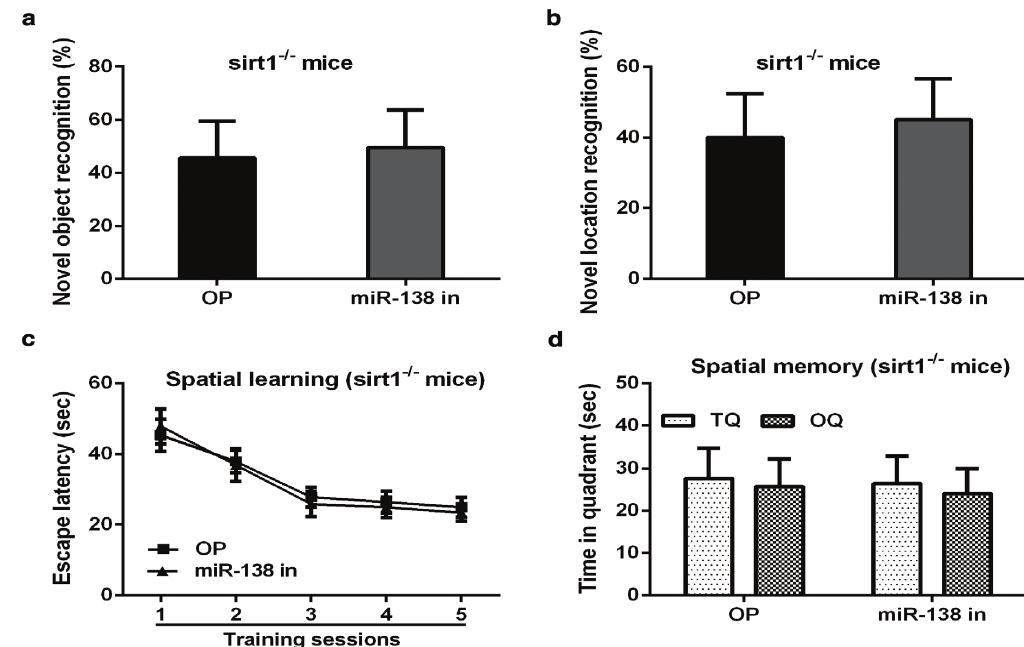
Fig. 7. The effects of inhibition of miR-138-5p attenuated cardiac surgery induced postoperative cognitive dysfunction